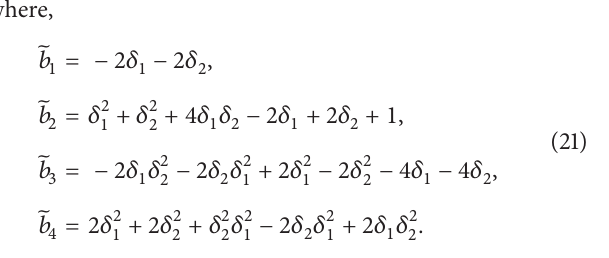
= 1 , 𝛼 = 0 , 𝛽 = 0 , 𝑘 2 = 𝑎 = 𝑎 8 9